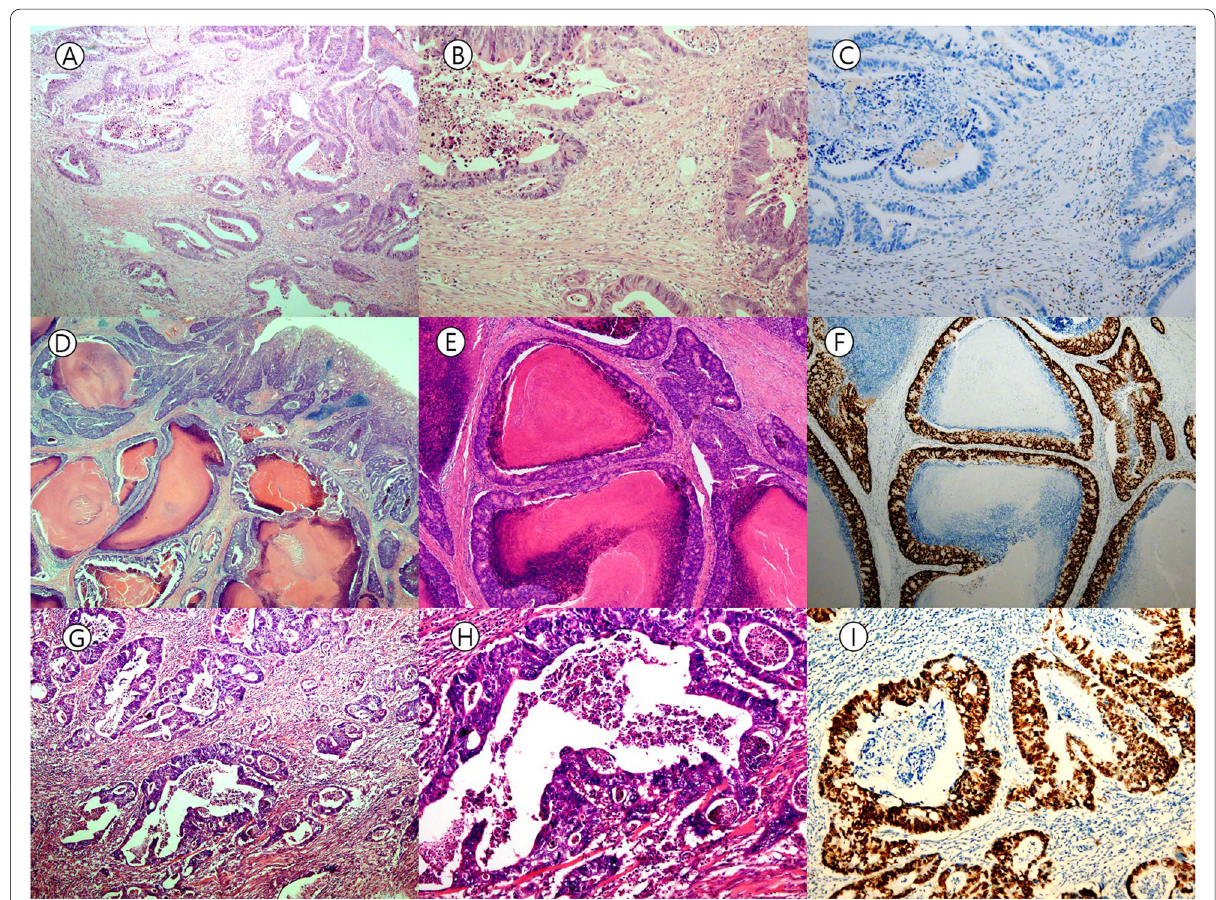
Fig. 3 Representative case with discrepancy between TP53 mutation and p53 IHC pattern. A & B Tumor area from which DNA was extracted for NGS analysis. Tumor cell purity is in acceptable range (Hematoxylin & Eosin, A: X4, B: X10 objective lens, respectively). C Null type pattern of p53 immunostaining is observed. No TP53 mutation was detected in this case (p53 immunohistochemistry, of the cecum with comedo‑type necrosis. Area from which DNA has been extracted is shown in E (Hematoxylin & Eosin, D: X1.25, and E: X4 objective lens, respectively). F Overexpression pattern of p53 immunostaining is noted in the absence of detectable TP53 mutation (p53 immunohistochemistry, 4 objective lens). G , H Moderately differentiated adenocarcinoma of the rectum. DNA has been extracted from the area × shown in G (Hematoxylin & Eosin, G: X4, and H: X10 objective lens, respectively). I Overexpression pattern of p53 immunostaining is noted in the absence of detectable TP53 mutation. This patient did not receive neoadjuvant chemoradiation therapy (p53 immunohistochemistry,